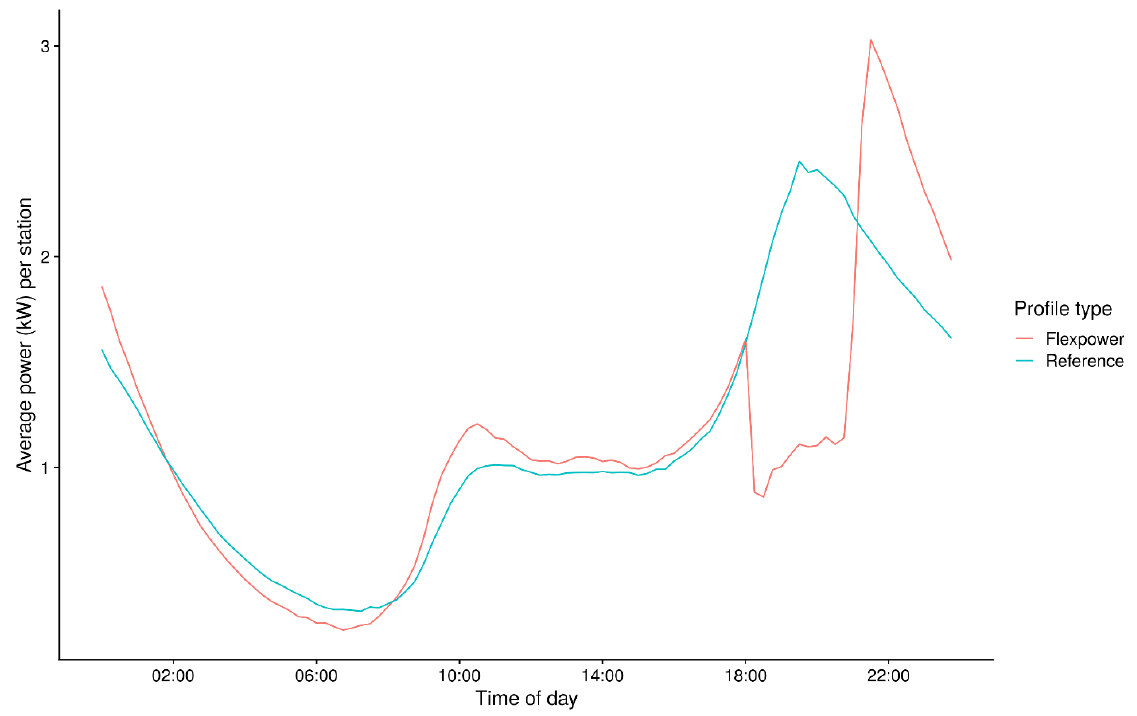
Figure 3. The average power per station over the day for Flexpower and reference stations. The plotted value represents the total grid load contribution of EV charging.